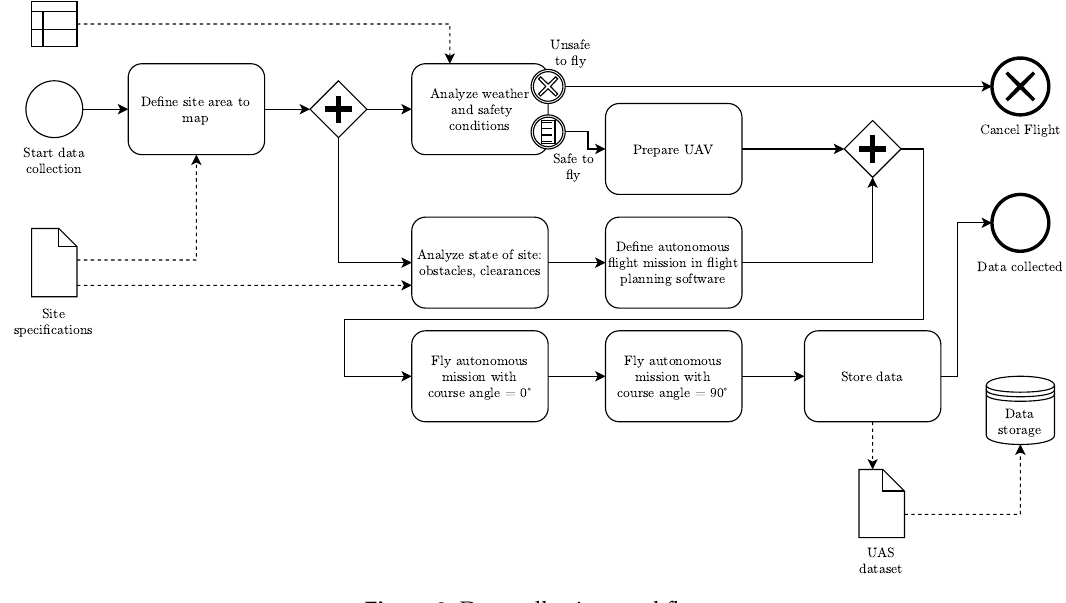
Figure 2. Data collection